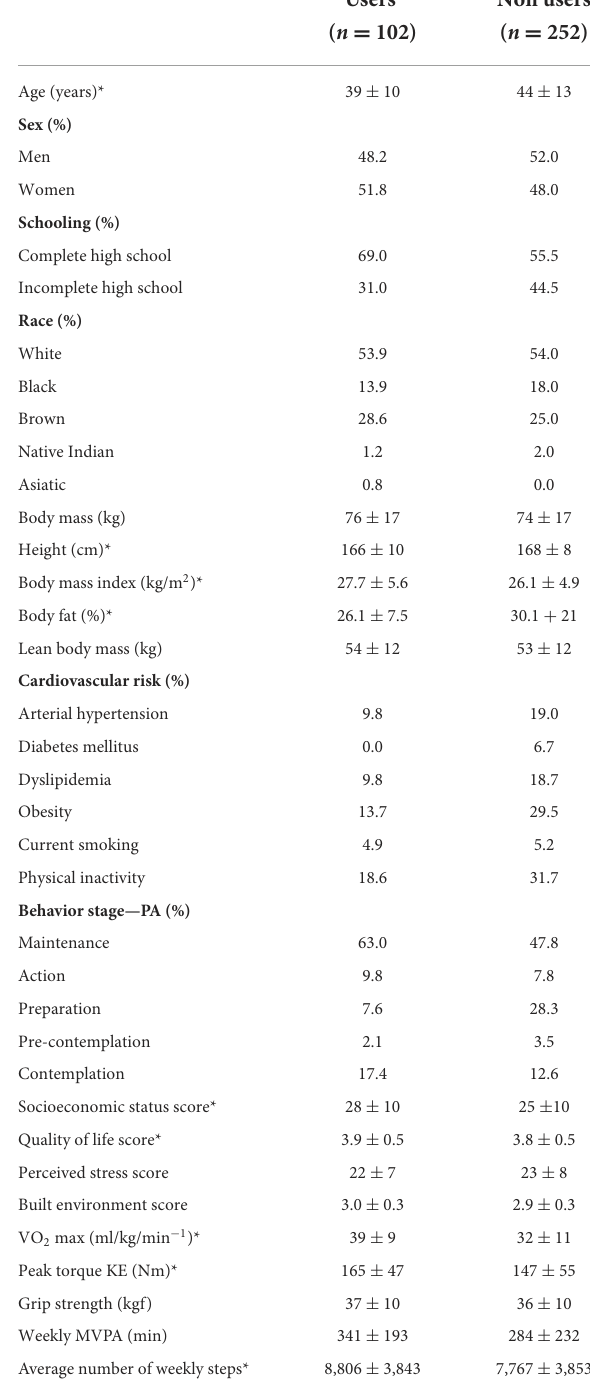
according to the use of smartphone applications to monitor daily physical